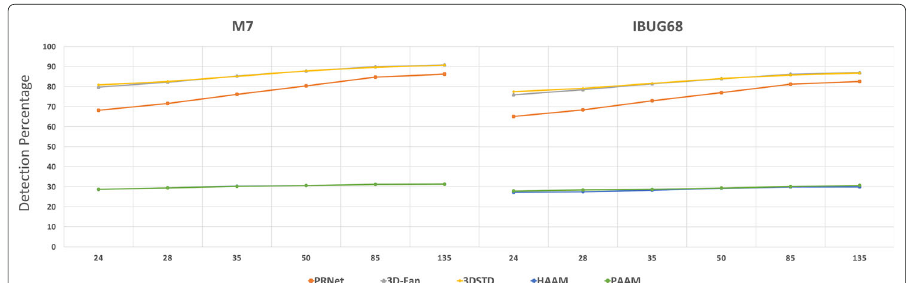
Fig. 9 Focal Length Varying: Left half of the chart uses M7, right half uses 68